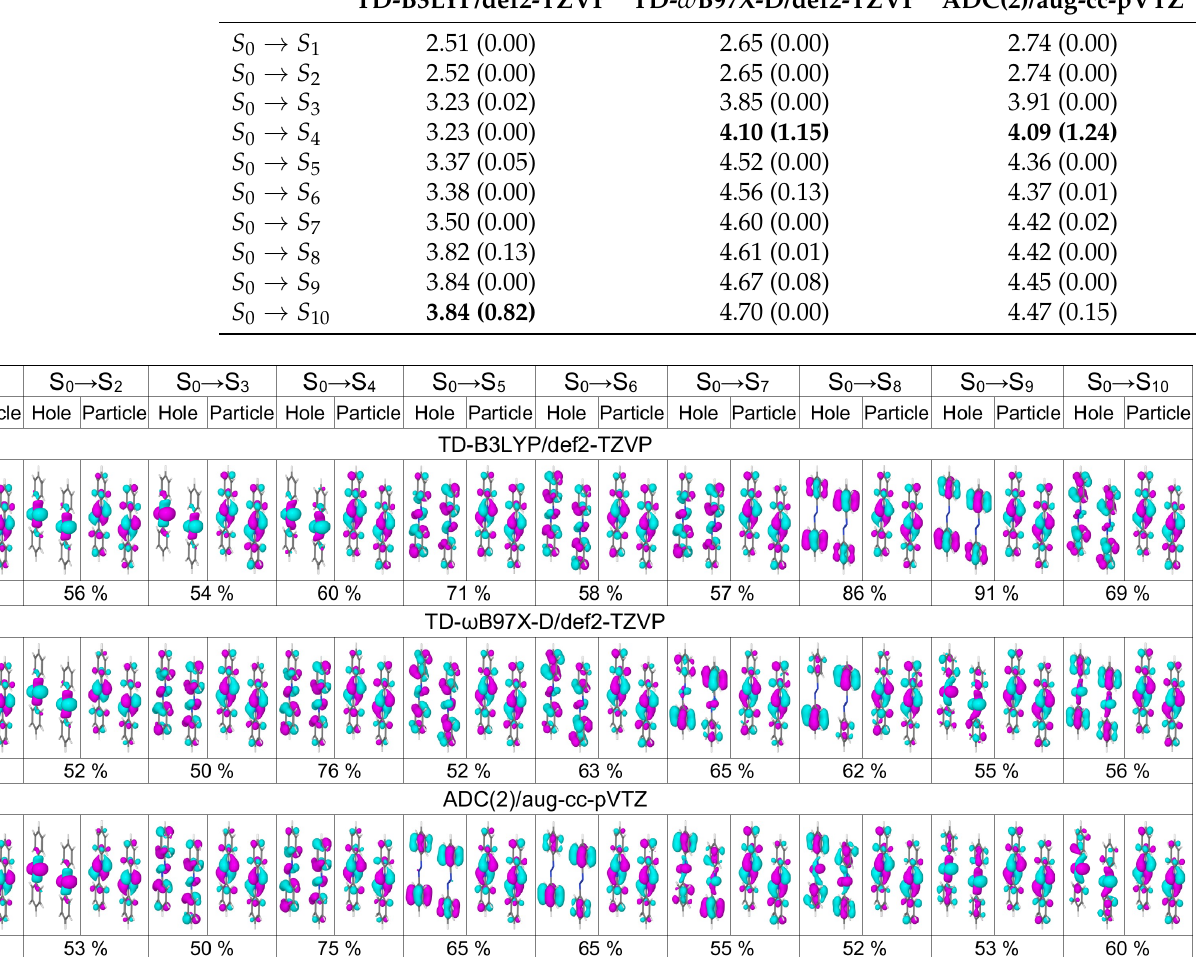
Figure 13. Dominant natural transition orbital pairs for the lowest ten transitions of the optimized dimer calculated at the TD- B3LYP/def2-TZVP ( top row ), TD- ω B97X-D/def2-TZVP ( middle row ), and ADC(2)/aug-cc-pVTZ ( bottom row ) levels of theory.